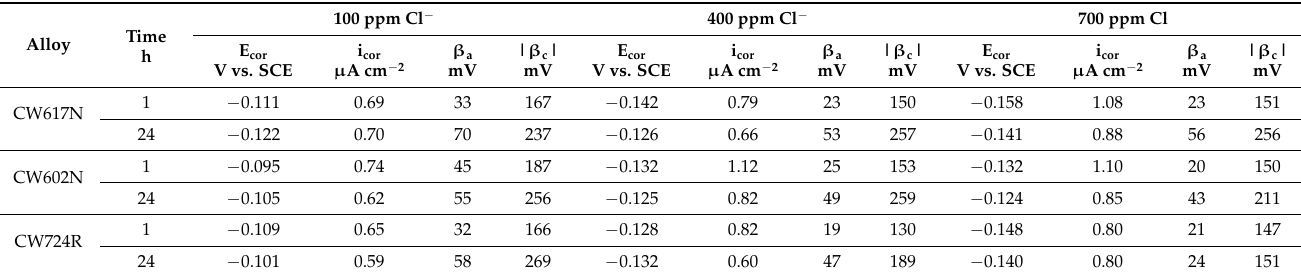
Figure 5. Polarization curves recorded on CW617N ( a ), CW602N ( b ), and CW724R ( c ) after 1 h (dashed lines) and 24 h (solid lines) immersion in the SDW solutions, at the three different chloride concentrations. Table 2. Corrosion potentials (E cor ), corrosion current densities (i cor ), and anodic ( β a ) and cathodic ( β c ) Tafel slopes obtained from the polarization curves.